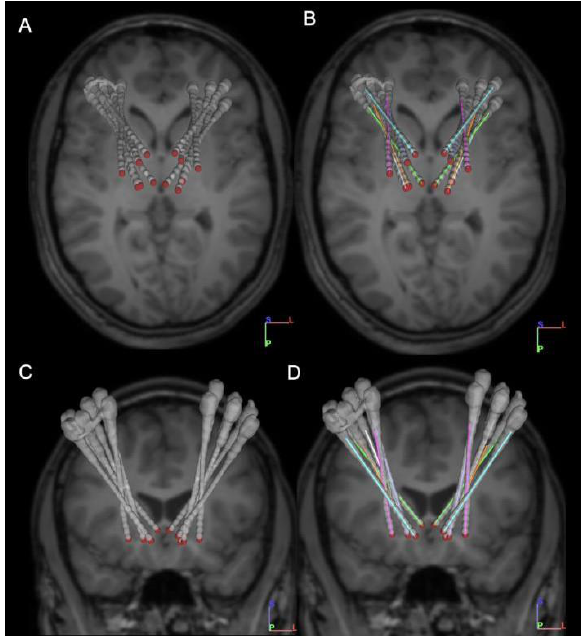
Figure 1. Axial ( A , B ) and coronal ( C , D ) views of the postoperative CT overlaid on the preoperative MRI, showing the lead locations for the Adtech stereo EEG